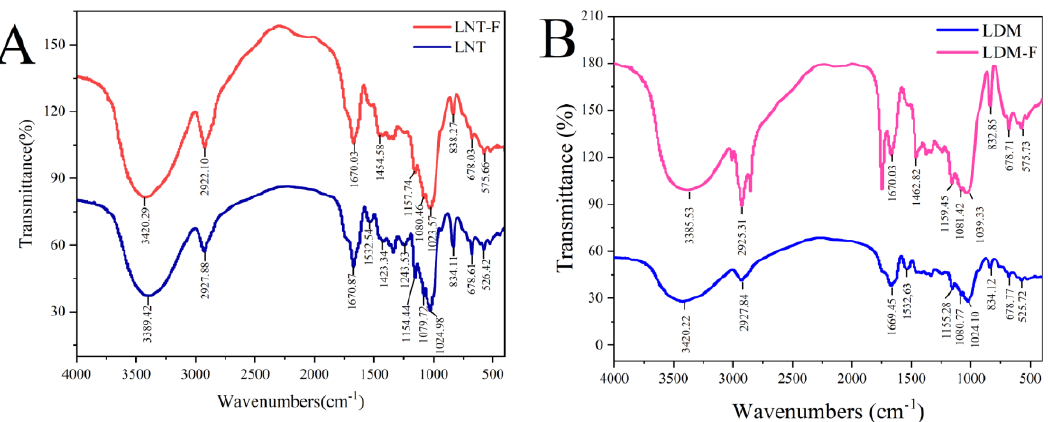
Figure 4. Fourier transform infrared spectra of lentinan. ( A ) Lentinula edodes powder (LNT) and fermented LNT (LNT-F) samples, ( B ) soybean powder (LDM) and fermented LDM (LDM-F) samples.